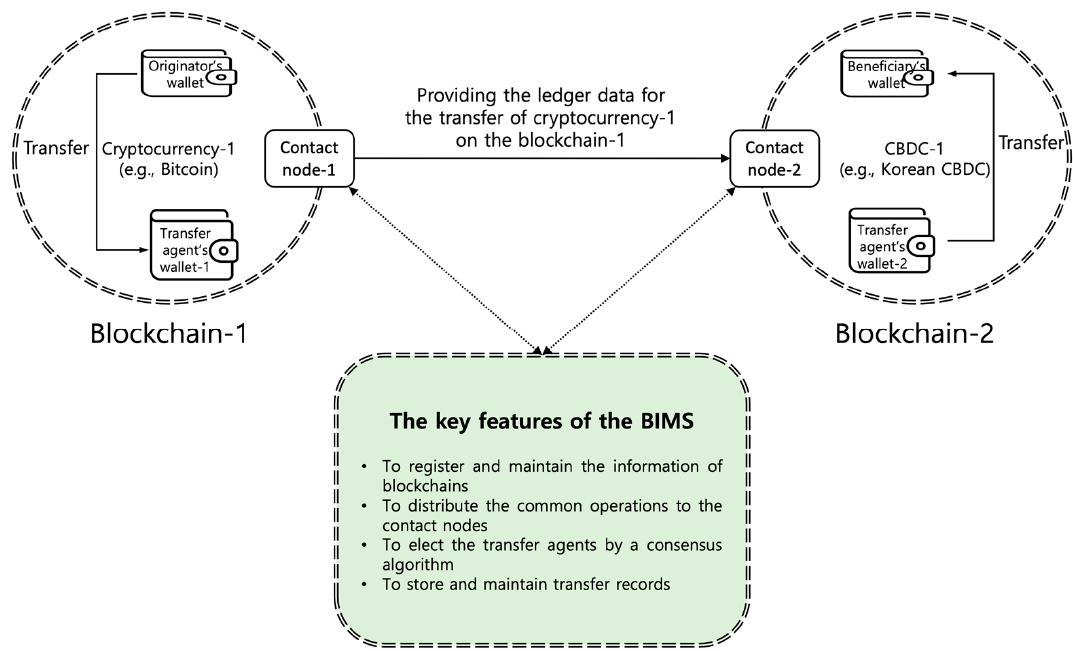
Figure 4. The service model for the transfer between cryptocurrency-1 and CBDC-1.